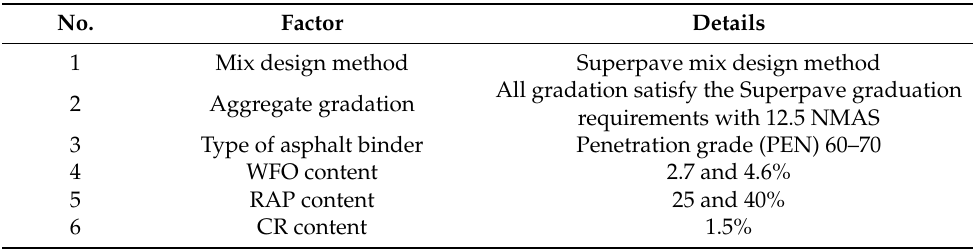
Table 1. Design matrix of the asphalt mixtures.